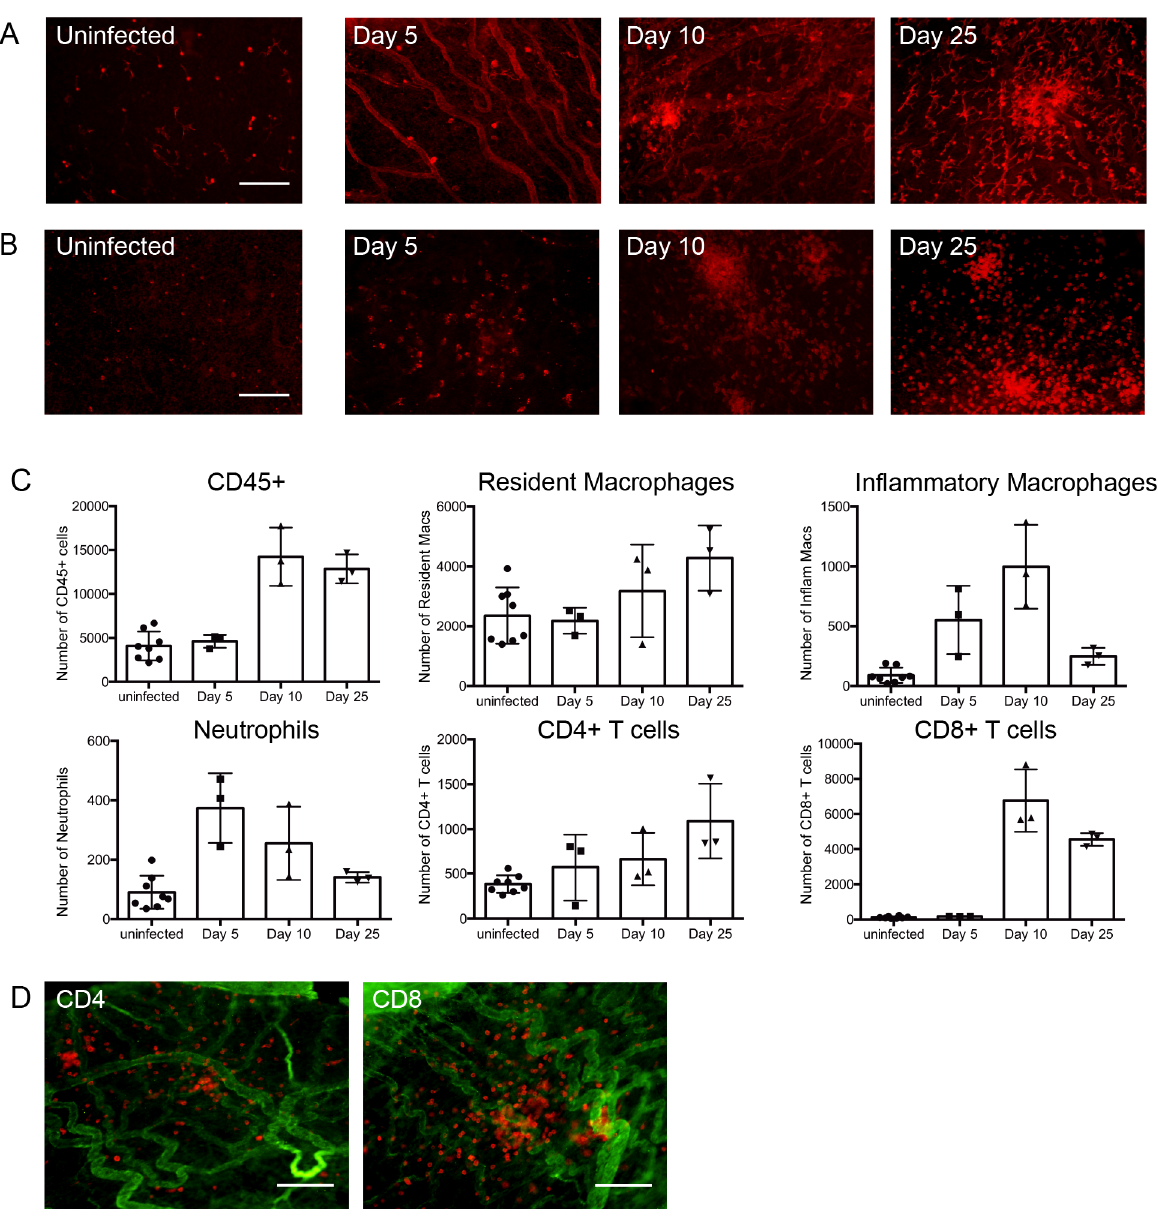
Fig 6. Leukocytes and lymphocytes, including T cells, infiltrate the iris after systemic MCMV infection. Whole- mounts of the iris at the indicated time points pi were prepared and stained with (A) anti-MHC-II or (B) anti-CD45 antibodies. (C) Mice were infected with MCMV, and at the indicated times pi single cell preparations of the iris prepared. Iris samples were pooled from 2–5 mice. The resulting pooled samples were stained with lineage specific antibodies and analysed by flow cytometry. The percentage of cells in specific populations are graphed as mean ± SEM where samples represent n (cid:21) 10 mice for each time point from 3 independent experiments. (D) Iris whole-mounts from mice at day 25 pi were stained with collagen IV (green) and CD4 (left panel) or CD8 (right panel) antibodies (red). Scale bar: 100 μm.